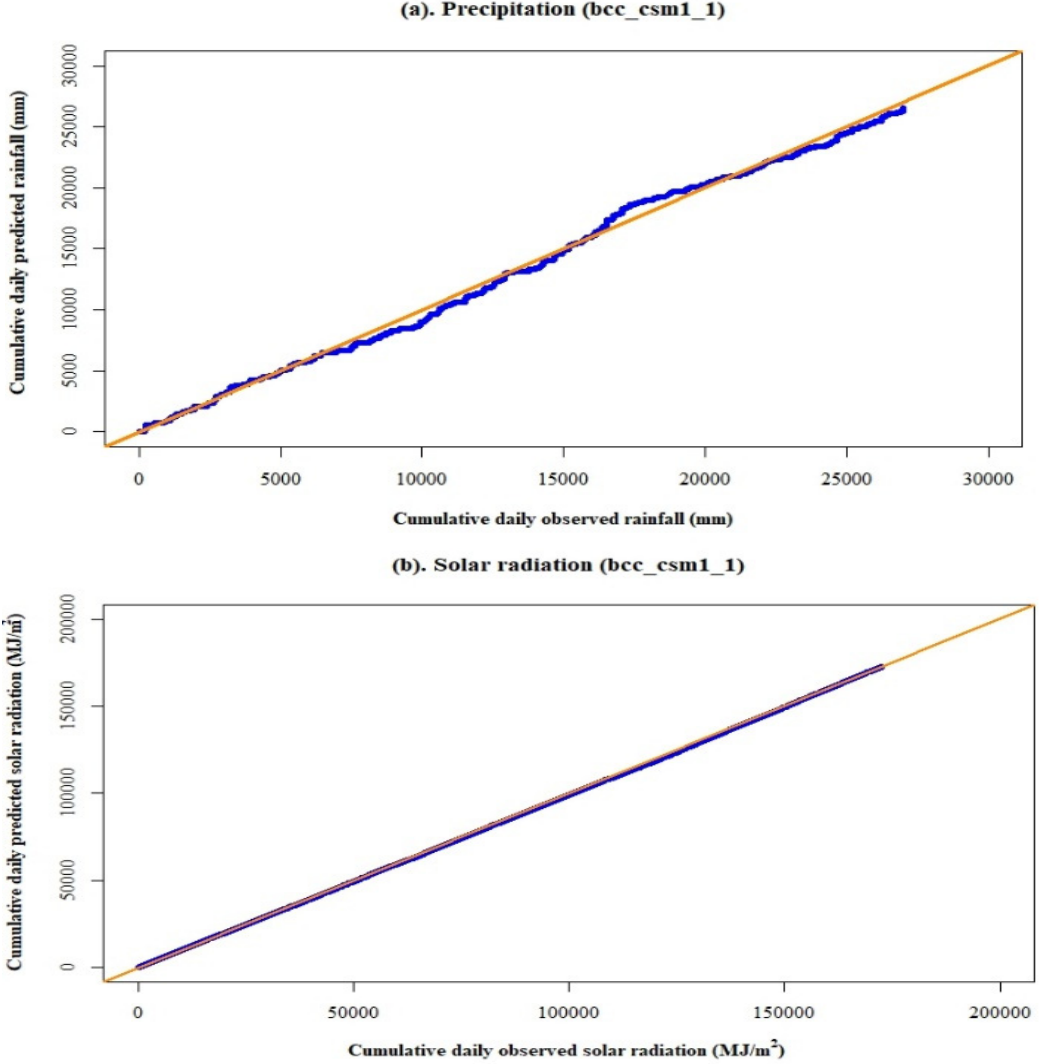
Figure 6. Double mass curve plots for the precipitation and solar radiation data by the model, bcc_csm1_1, for the baseline period (1980–2004).